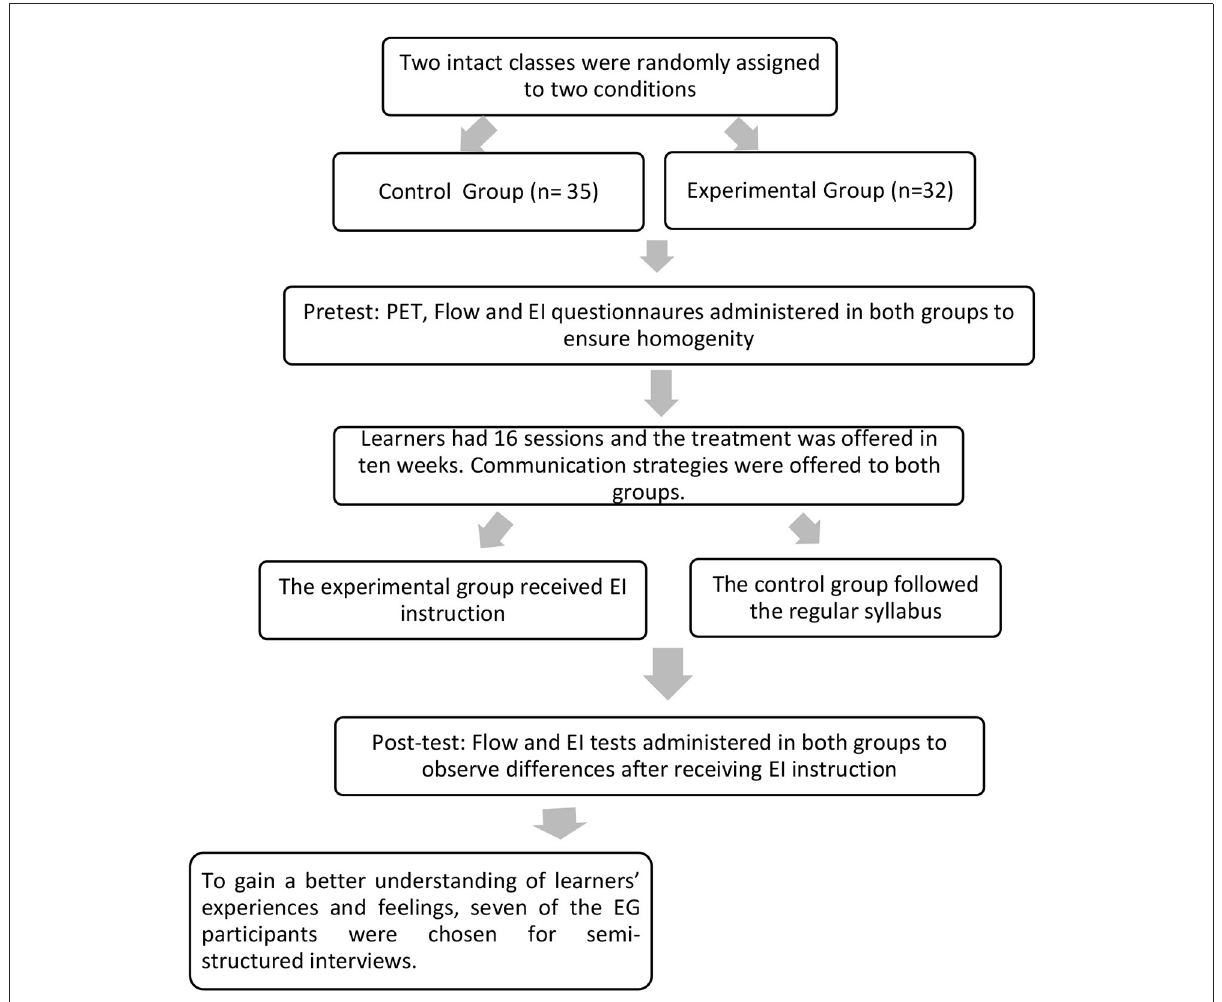
FIGURE1 Design of the